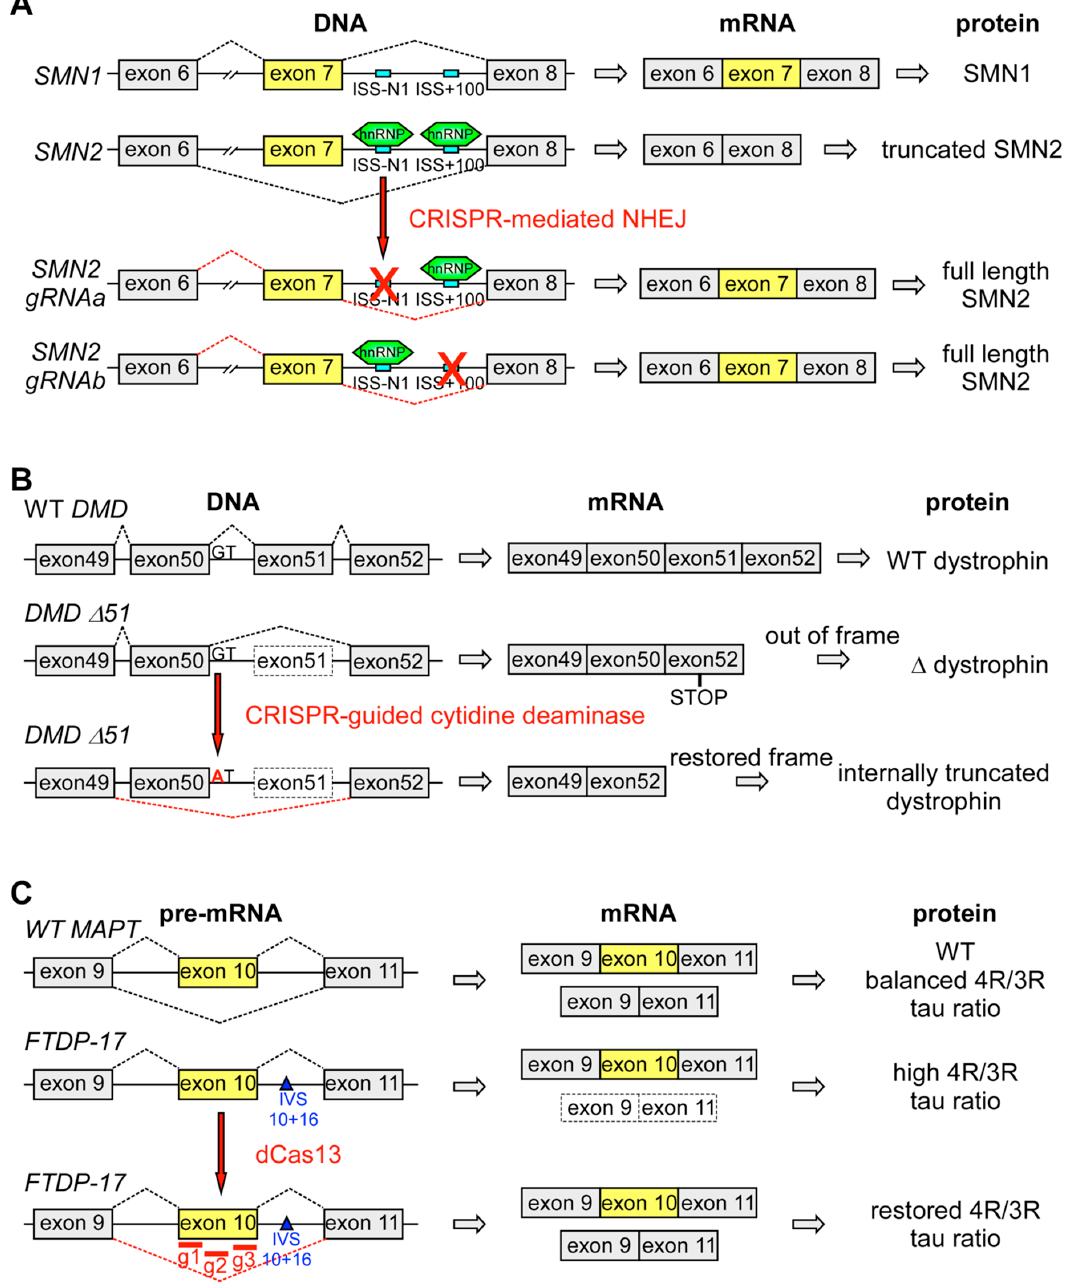
Figure 2. CRISPR-based splicing therapies ( A ) CRISPR-mediated non-homologous end joining (NHEJ) disrupts intronic splicing silencer (ISS) sites in intron 7 of SMN2 preventing binding of hnRNPs, thus favoring inclusion of exon 7, normally not present in SMN2 . This helps compensate for mutated SMN1 . ( B ) Deletion of exon 51 of DMD leads to a frameshift resulting in a truncated nonfunctional dystrophin. CRISPR-guided cytidine deaminase mutates the 5 ′ splice site of exon 50, leading to skipping of exon 50, which restores the reading frame. The resulting internally truncated dystrophin is able to restore partially WT function. ( C ) AS of MAPT exon 10 leads to formation of 4R and 3R tau isoforms. The FTDP-17-associated IVS 10 + 16 mutation results in increased exon 10 inclusion and higher 4R tau levels. Expression of dCas13 together with three gRNAs targeting the exon 10 splice acceptor site and two putative exonic splicing enhancers (ESEs) promotes skipping of exon 10, thus restoring a balanced 4R/3R tau ratio. Schemes adapted from [149,161,164] .